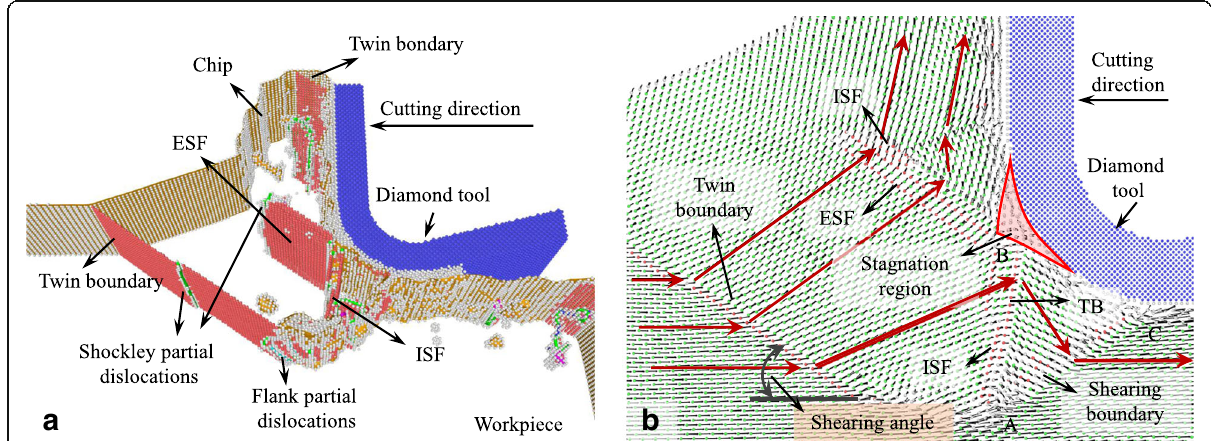
Fig. 5 a Snapshots of the microstructure evolution at cutting direction of {110}<001>, b displacement vector sliced at 4 nm in z direction